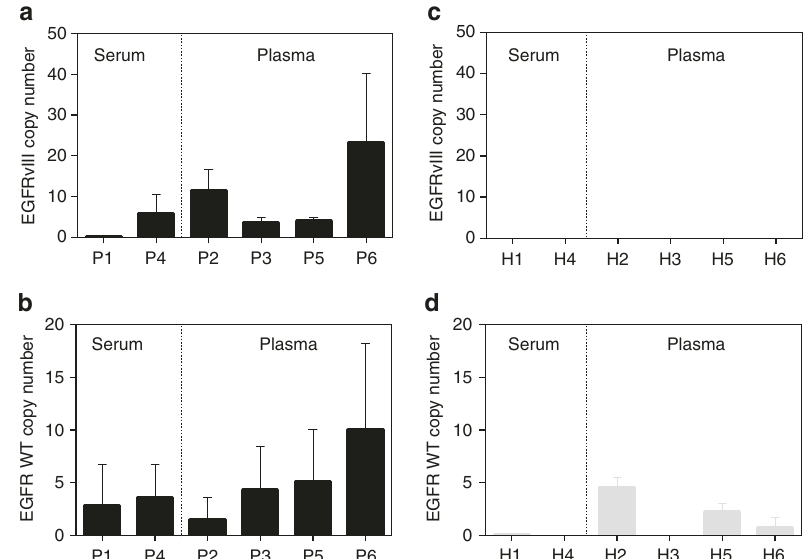
Fig. 3 Quanti fi cation of EGFRvIII mRNA in serum and plasma-derived extracellular vesicles using droplet digital PCR. EGFRvIII and EGFR WT mRNA levels were quanti fi ed from six GBM patients ( a ) and ( b ) respectively. Tumor-derived EVs were isolated using the micro fl uidic platform coated with a cocktail of antibodies, EVs were lysed, and RNA extracted directly from the chip. Droplet digital PCR was used to quantify EGFRvIII, EGFR WT and levels were normalized to total sample input. In ( c ) and ( d ) similar analysis was conducted for six healthy donors (H). Values are expressed as absolute copy numbers of EGFRvIII and EGFR WT mRNA ( n = 3 technical replicates; ±